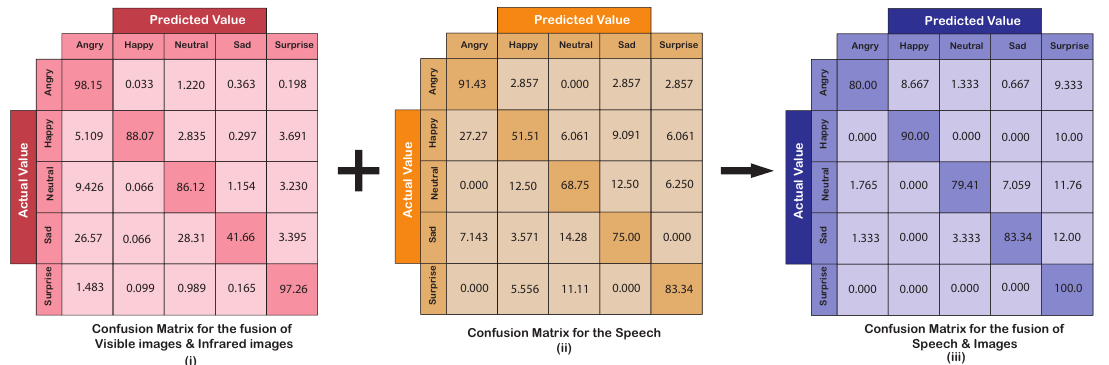
Figure 8. Confusion matrix for the images, the speech, and the fusion of images and speech.